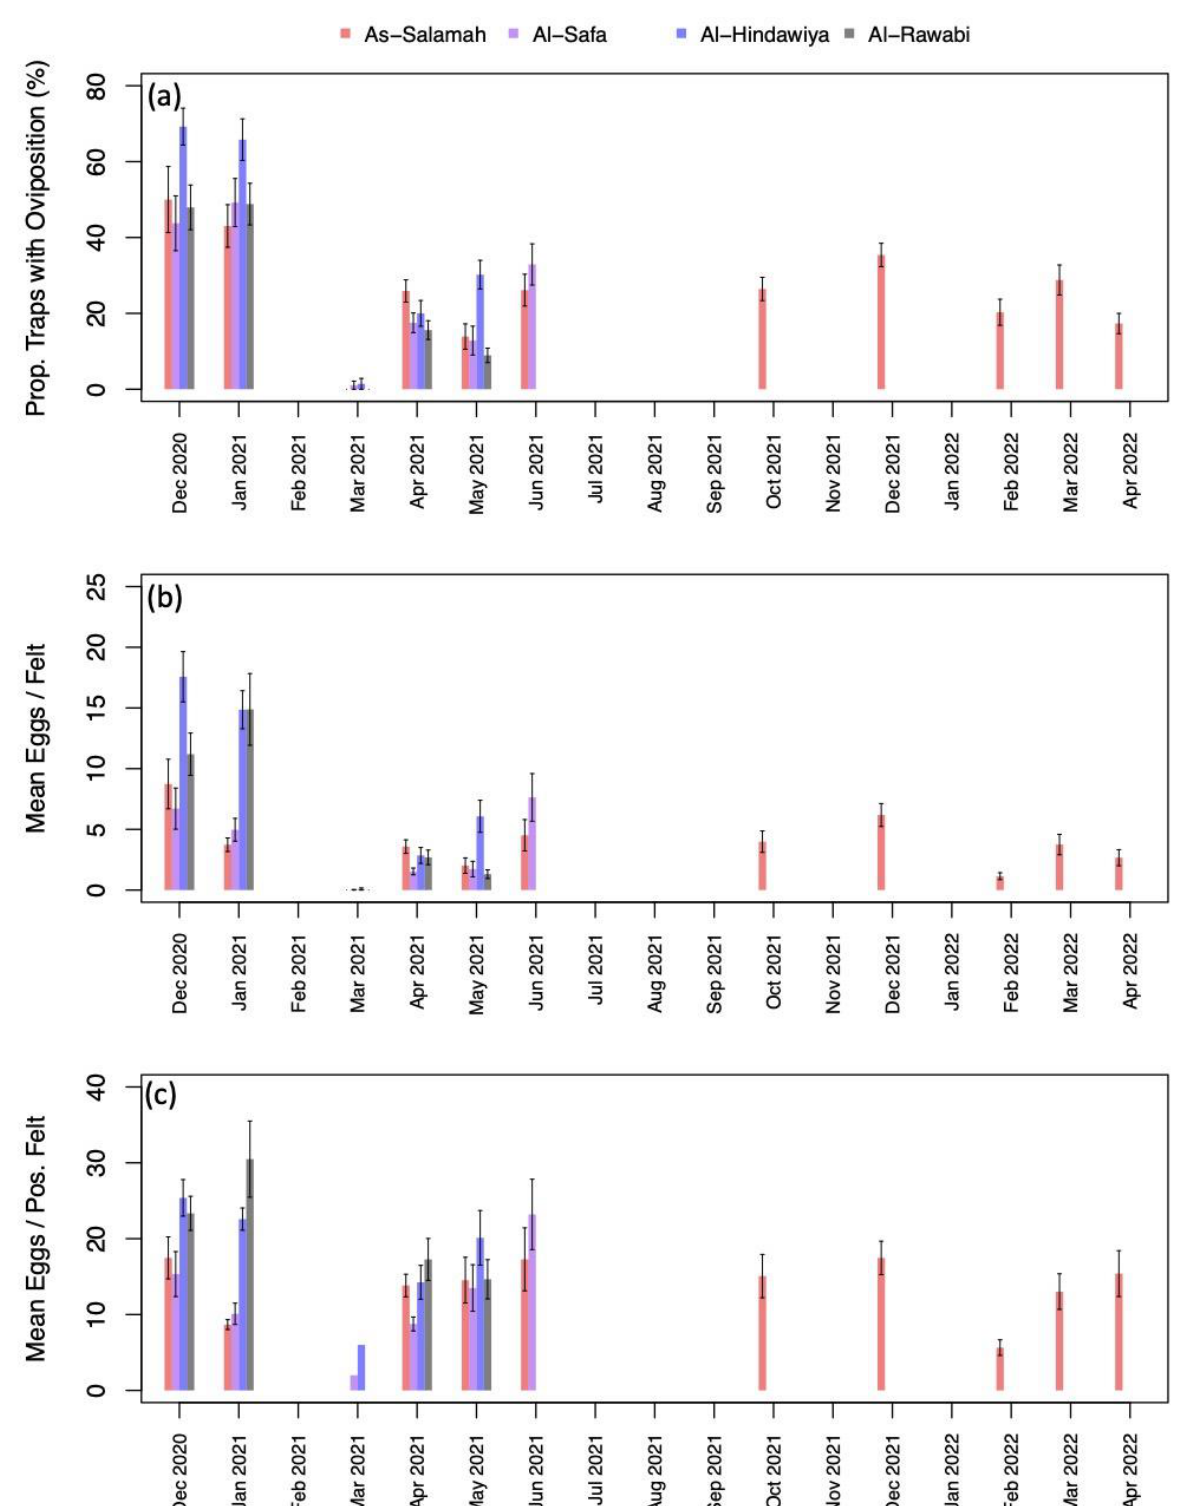
Figure A2. ( a ) percentage of traps with oviposition by month and year (aggregated across study sites); ( b ) mean number of eggs deposited per felt by month and year (aggregated across sites); and ( c ) mean number of eggs deposited per positive felt by month and year (aggregated across sites). Black intervals extending from barplots in ( a – c ) show +/– one standard error.